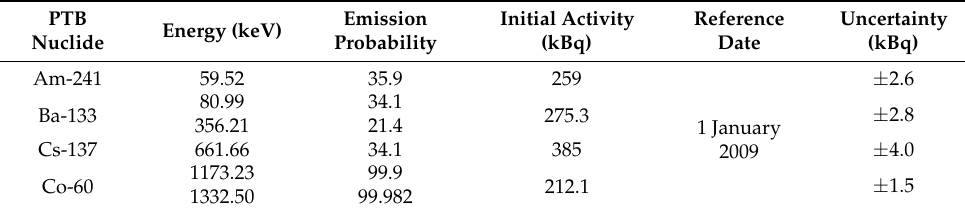
Table 2. The activities and other specifications for point sources that are used in this